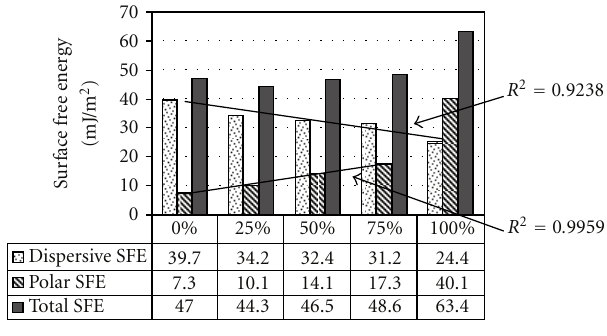
Figure 7: Dispersive ( γ D ), polar ( γ P ), and total ( γ TOT ) components of surface free energy (SFE) for polymer composites of di ff erent BAG particles wt. % (0%, 25%, 50%, 75%, and 100%, resp.) cal- culated using the Owens-Wendt approach.